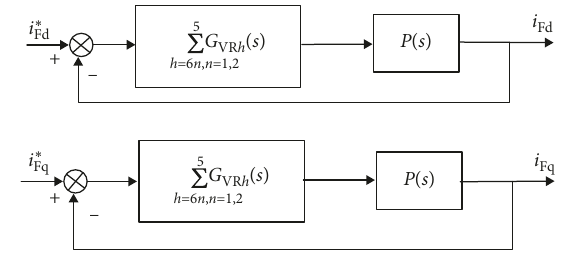
Figure 3: Current control block diagram based on multi-VR controller.